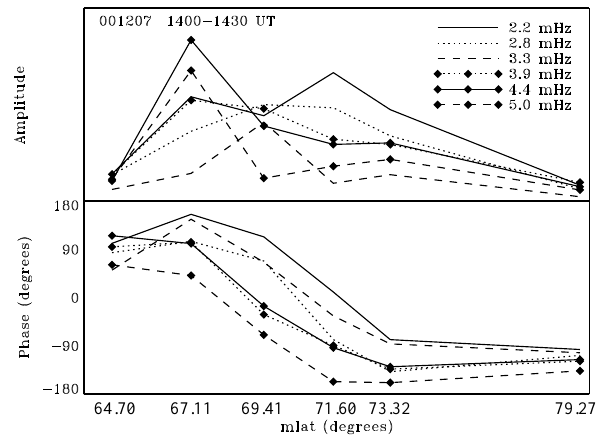
Fig. 3. Latitudinal variations of the Fourier amplitude and phases of the X -component along the CANOPUS Churchill